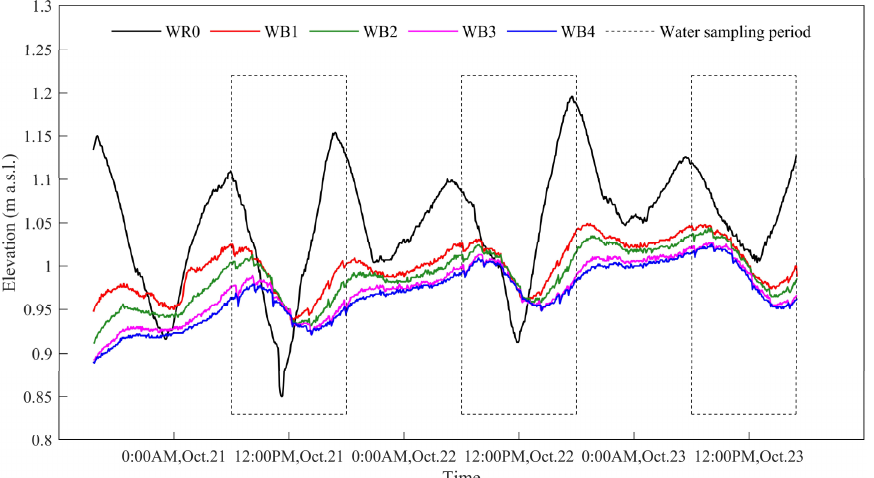
Figure 3. Fluctuation curve of water level in the river channel (WR0) and the four riparian observation wells (WB1–WB4) during the monitoring period from 21 to 23 October 2021.